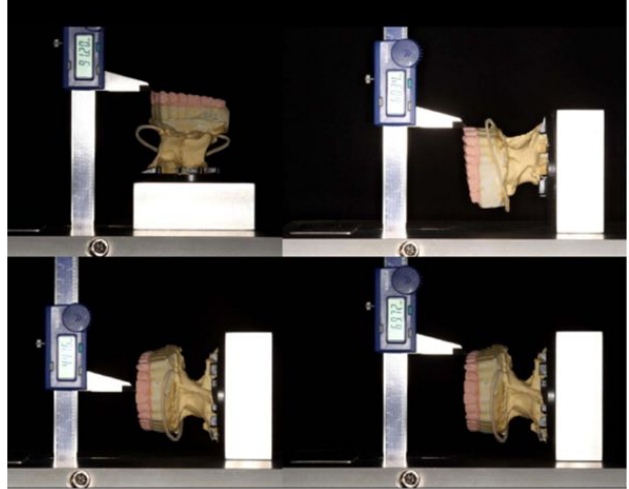
Fig. 4. Measurements realized in vertical and anteroposterior dimension with Erickson platform and digital caliper.